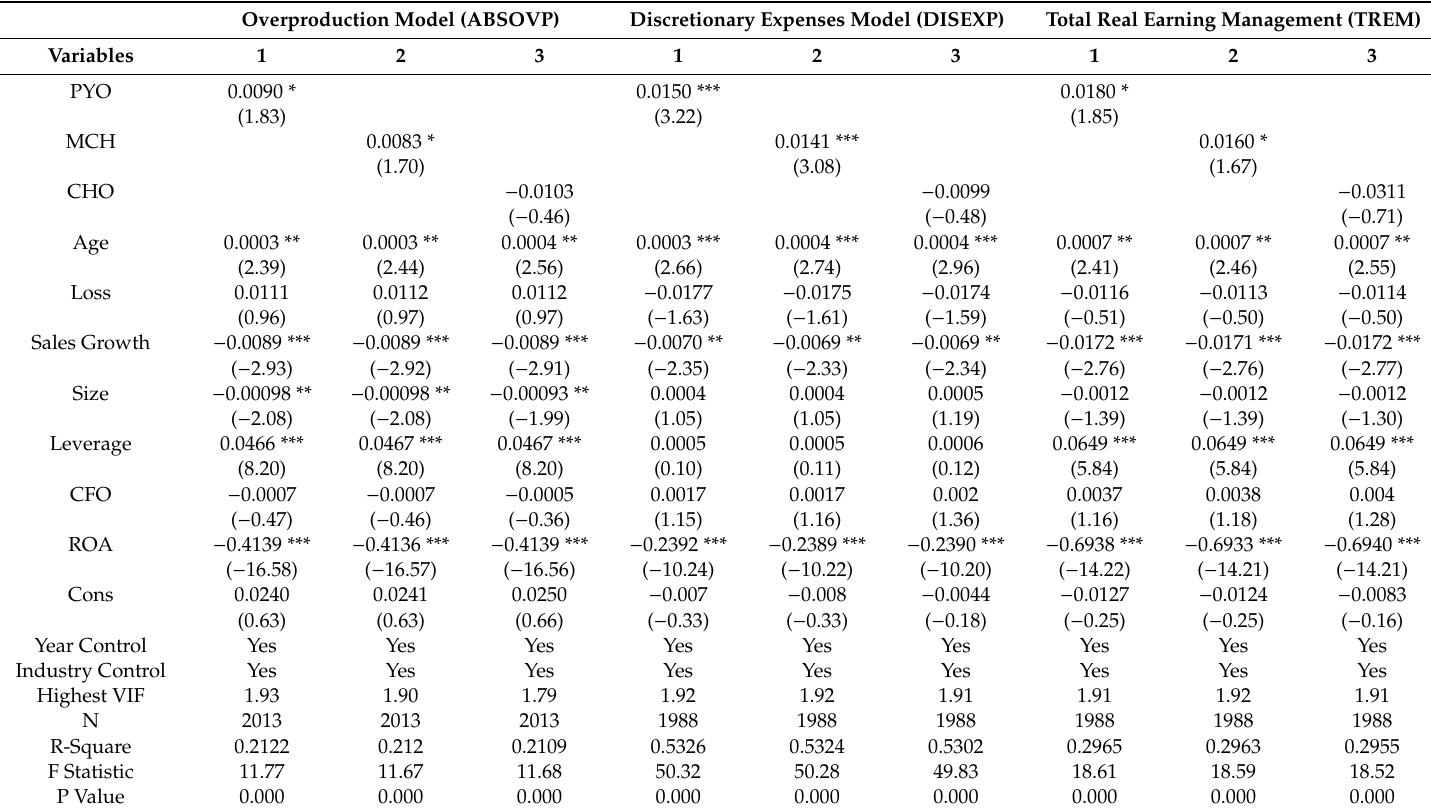
Table 6. Results for real earnings management models (Roychowdhury